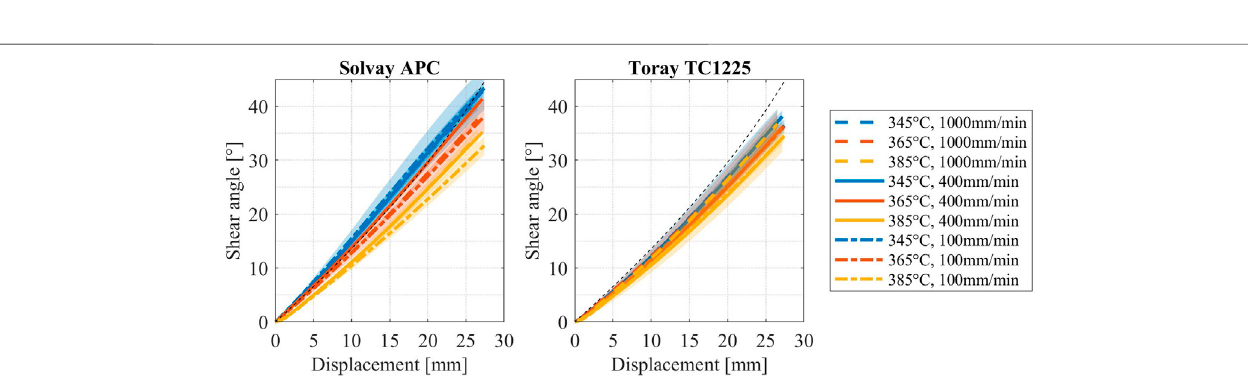
FIGURE 5 | Shear angle measured by the video extensometer related to the cross-head displacement. The black dashed line indicates the theoretical shear angle according to pin-jointed net (PJN) assumptions ( Eq. 1 ). The shaded areas indicate one standard deviation around the mean based on three measurements.